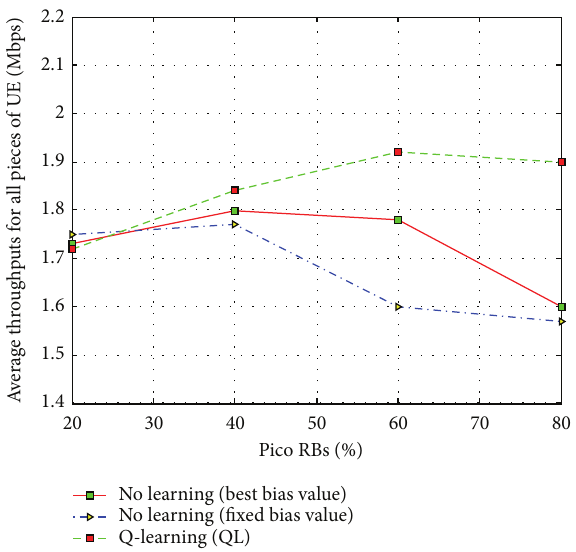
Figure 8: Average throughput for all UE [8].